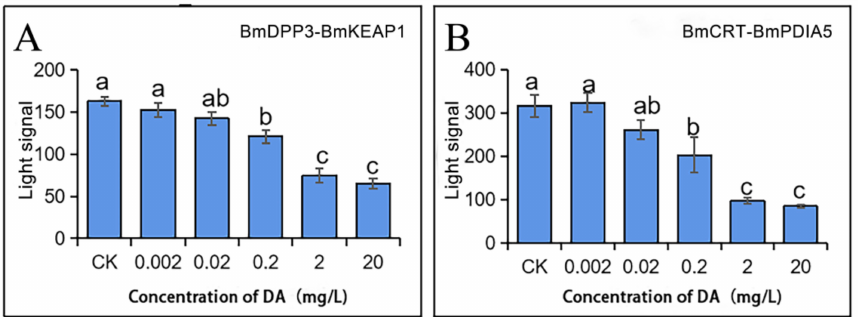
Figure 4. Changes in the light signal of two groups of interacting proteins after DA treatment.